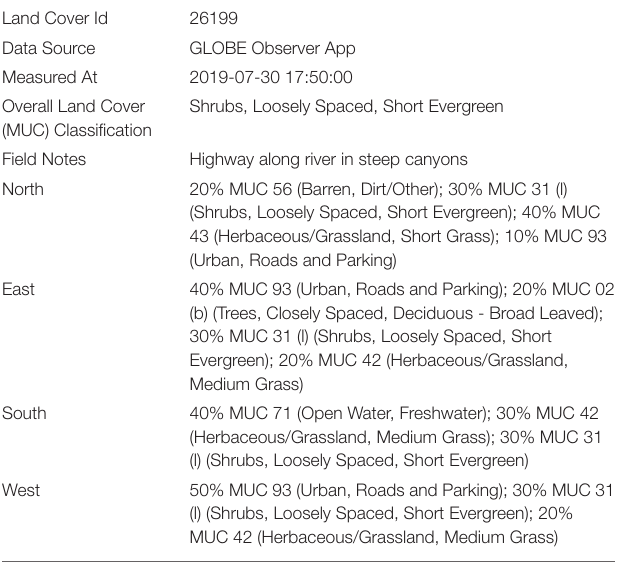
TABLE 3 | GLOBE Observer sample summary data table for a single raw data point.